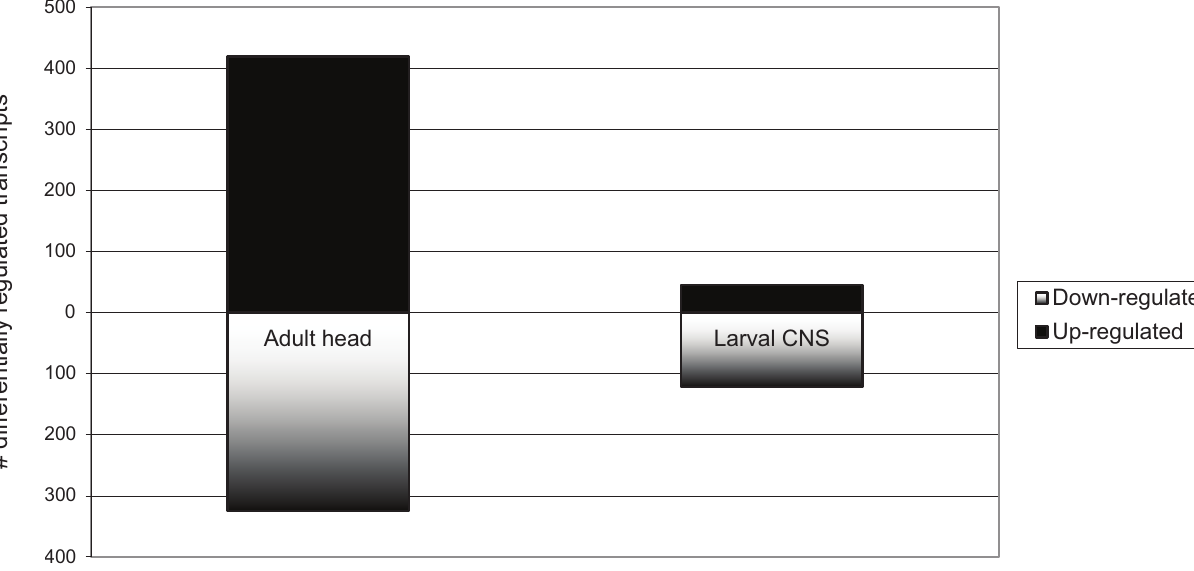
Figure 3. Number of differentially expressed transcripts in Btk defective flies: A differential fold-change cut-off of the Signal Log Ratio (SLR) . 1,2 (difference of means between Btk29A ficP and revertant ( Btk29A (fic Exc1–16) ) was applied to define genes whose expression was significantly different from that of the revertant and Btk29A ficP . Bar-graph showing the number of up- and down-regulated transcripts, respectively, in adult head and larval CNS after the pair-wise comparison of revertant ( Btk29A (fic Exc1–16) ) and Btk29A ficP